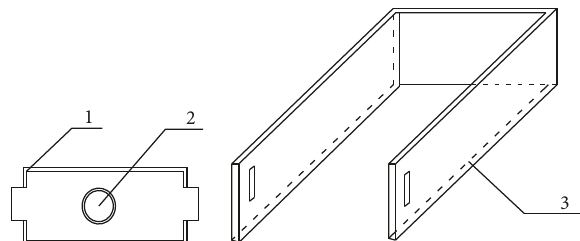
Figure 5: Filling groove. 1, head board; 2, filling hole; 3, side board.